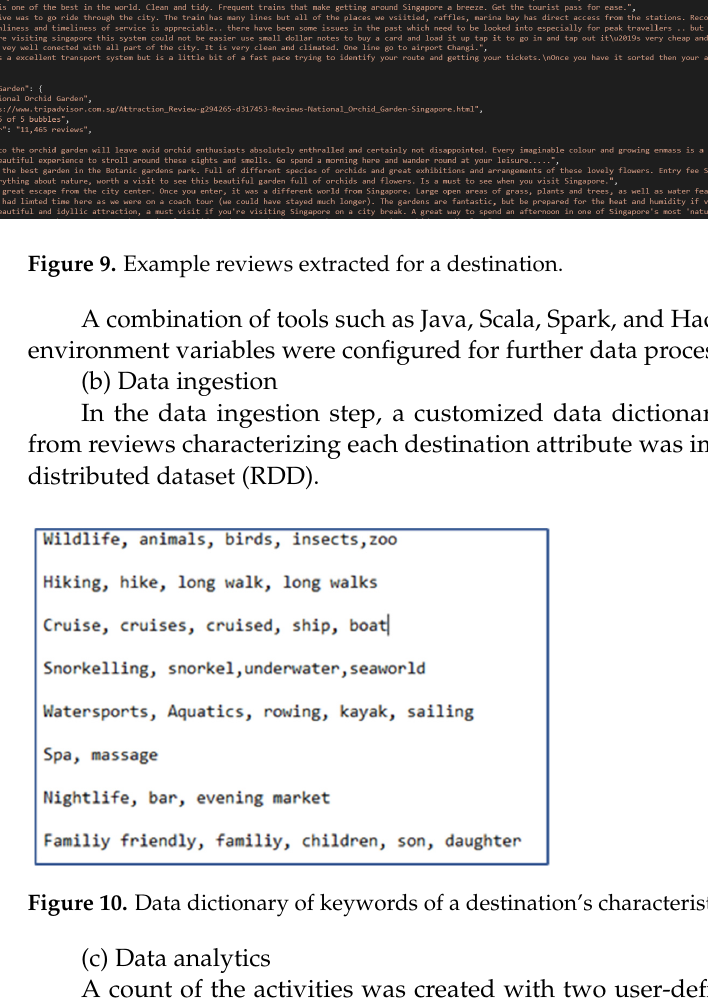
Figure 12. An output of thematic analysis of destination reviews.